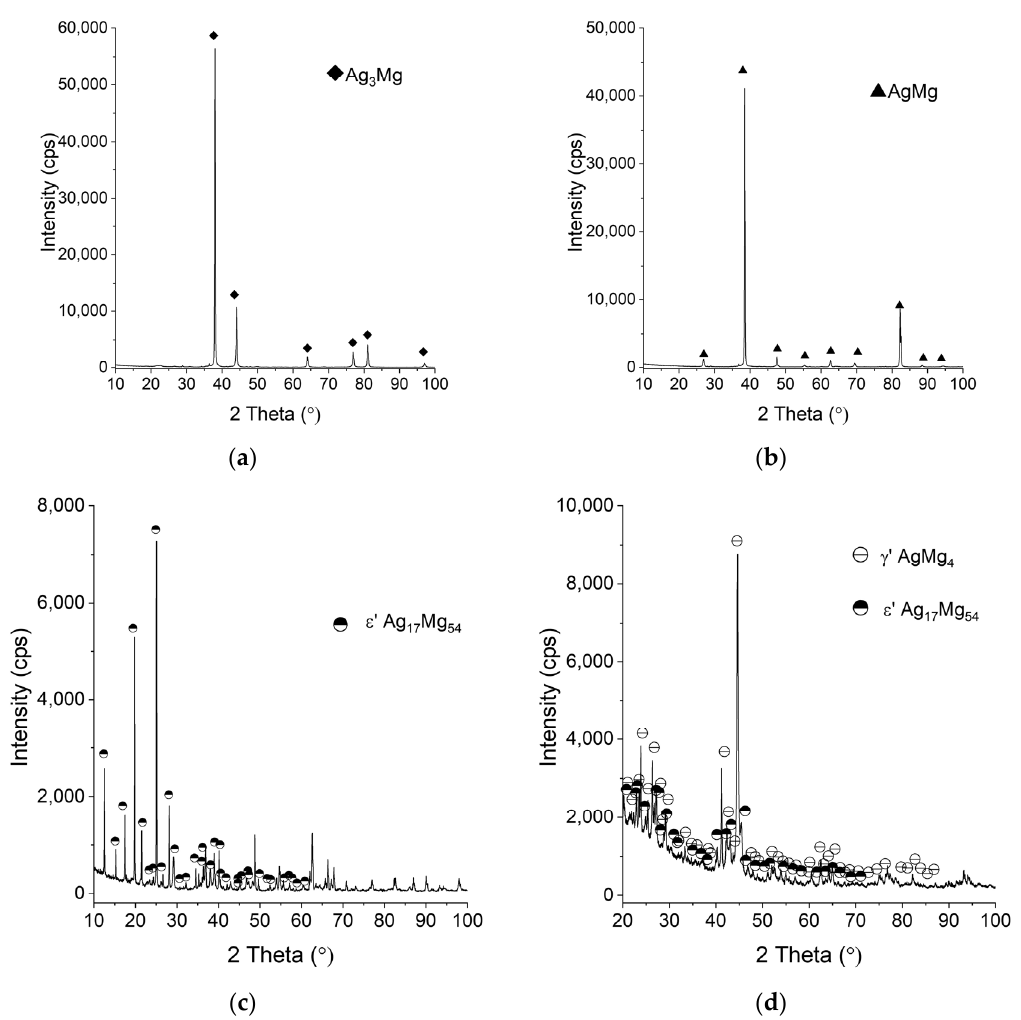
Figure 3. XRD patterns for Ag-Mg alloys: ( a ) Alloy 10 ( b ) Alloy 8 ( c ) Alloy 6, and ( d ) Alloy 5.